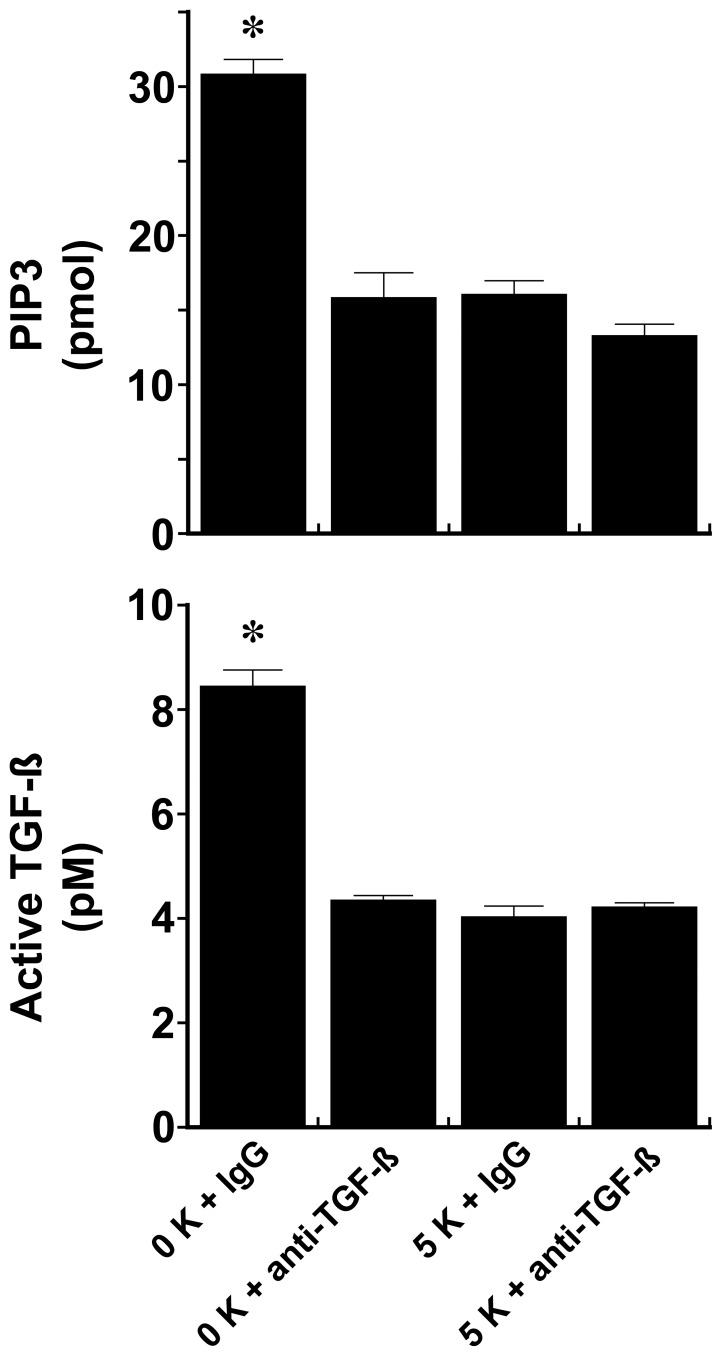
Endothelial cells were incubated overnight in medium that contained [KCl], 0 and 5 mM, and a neutralizing anti-TGF-ß antibody or nonspecific IgG.The observed increase in PIP3 content in cells in the low-potassium medium was inhibited by the addition of the anti-TGF-ß antibody, which did not affect PIP3 levels in cells incubated in medium containing 5 mM [KCl]. Addition of anti-TGF-ß antibody reduced active TGF-ß levels to that observed when medium [KCl] concentration was 5 mM. *p-value <0.05 compared to the other two groups. n = 6 experiments in each group.